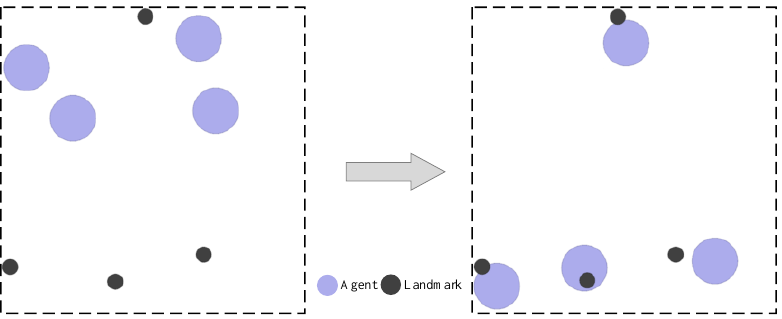
Figure 10. Diagram of the training effect of CMCL algorithm in cooperative environment.